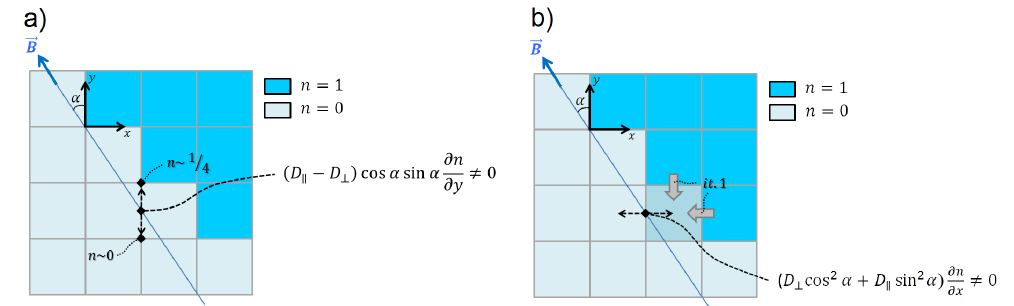
Figure 3. Sketch illustrating the numerical diffusion, because of the iterative nature of numerical algorithms, after one iteration, the cross-diffusion term allows for permeability across the magnetic field line at a higher rate than would normally be allowed for perpendicular diffusivity; ( a ) numerical diffusion in the vertical, y , direction; ( b ) x -directed numerical